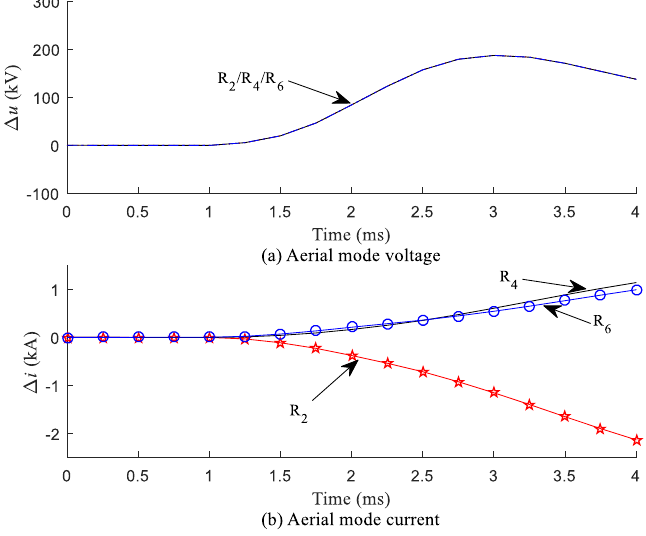
Figure 10. The aerial mode components that were detected by R 2 , R 4 , and R 6 for an external fault: the ( a ) aerial mode voltage and the ( b ) aerial mode current.